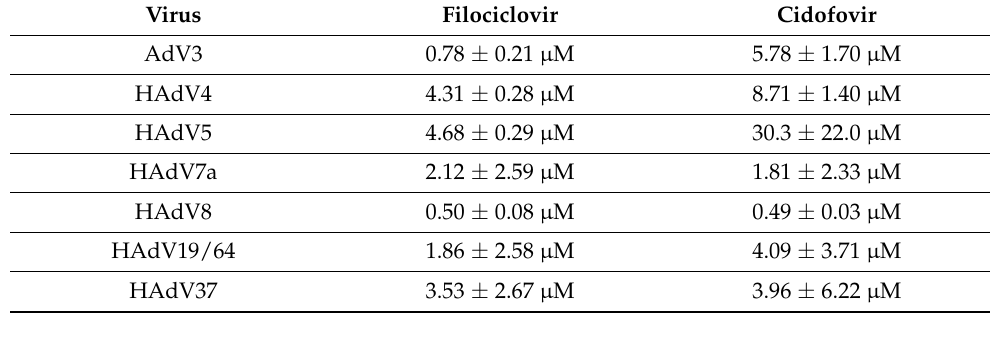
Table 1. Mean and standard deviations of EC 50 from 3 plaque reduction assay (PRA) trials. Virus